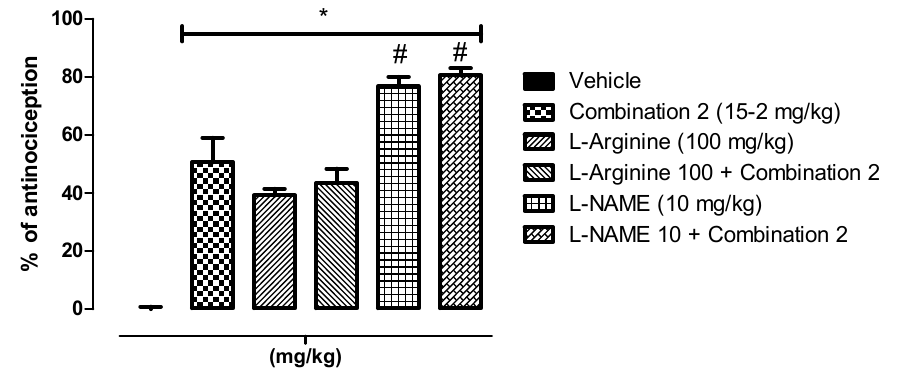
Figure 5. Involvement of the L -Arginine/NO/cGMP pathway. Overall effect of the doses of L -arginine (100 mg/kg) and L -NAME (10 mg/kg) on combination 2 (15 mg PoPEx/2 mg ASA) was evaluated. The rats were pretreated with an intraperitoneal injection of L-arginine and L -NAME. * = statistically significant effect ( p < 0.05) of all groups versus vehicle. # = statistically significant effect ( p < 0.05) of L -NAME (10 mg/kg) and L-NAME 10 + Combination 2 versus Combination 2 (Determined by one-way ANOVA followed by the Bonferroni test). Each bar corresponds to the mean ± EE of six